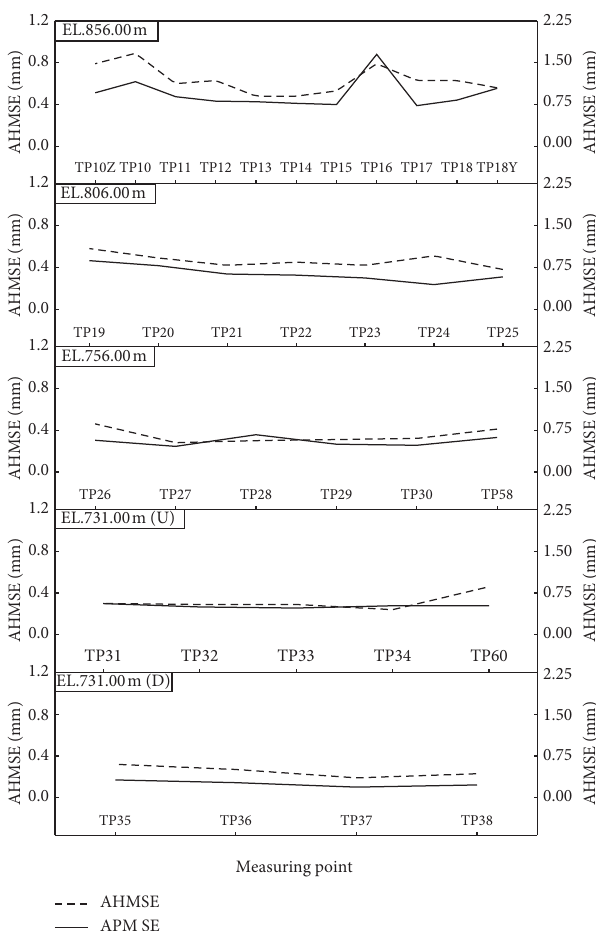
Figure 8: AHMSE and APMSE of the monitoring data.